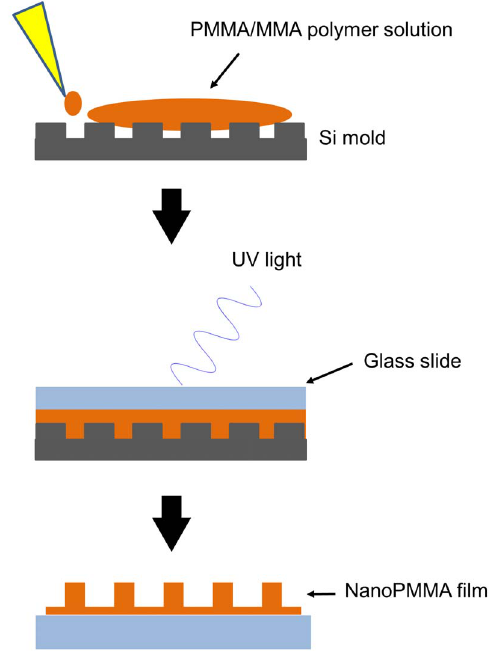
Figure 1. Capillary assisted UV lithography polymerization method was used to produce PMMA films with nanotopogra-